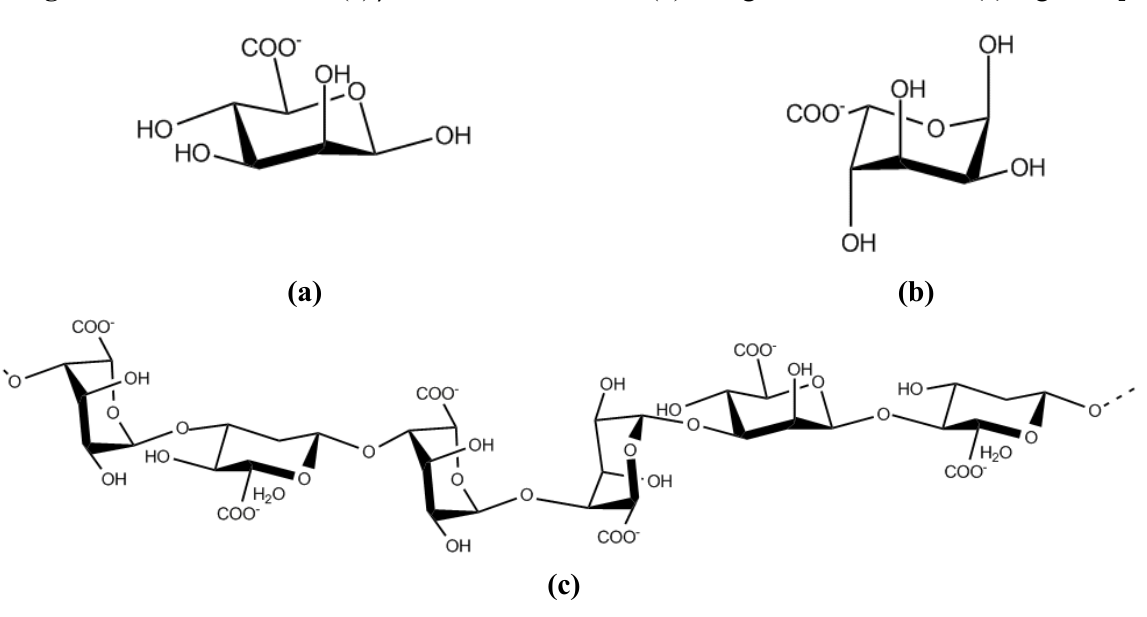
Figure 8. The structure of (a) β - D -mannuronic acid, (b) α - L -guluronic acid and (c) alginate